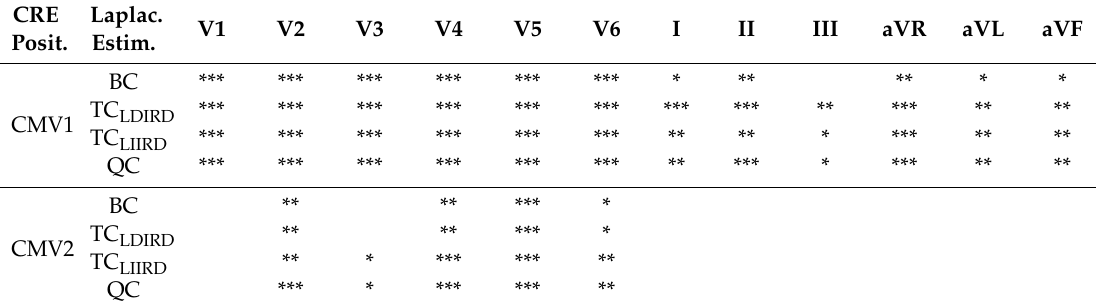
Table 2. Statistically significant differences 1 between NAP values for Laplacian estimates (BC, TC LIIRD , TC LDIRD , and QC) at the two positions (CMV1 and CMV2) and NAP values for standard 12-lead ECG. CRE Posit.